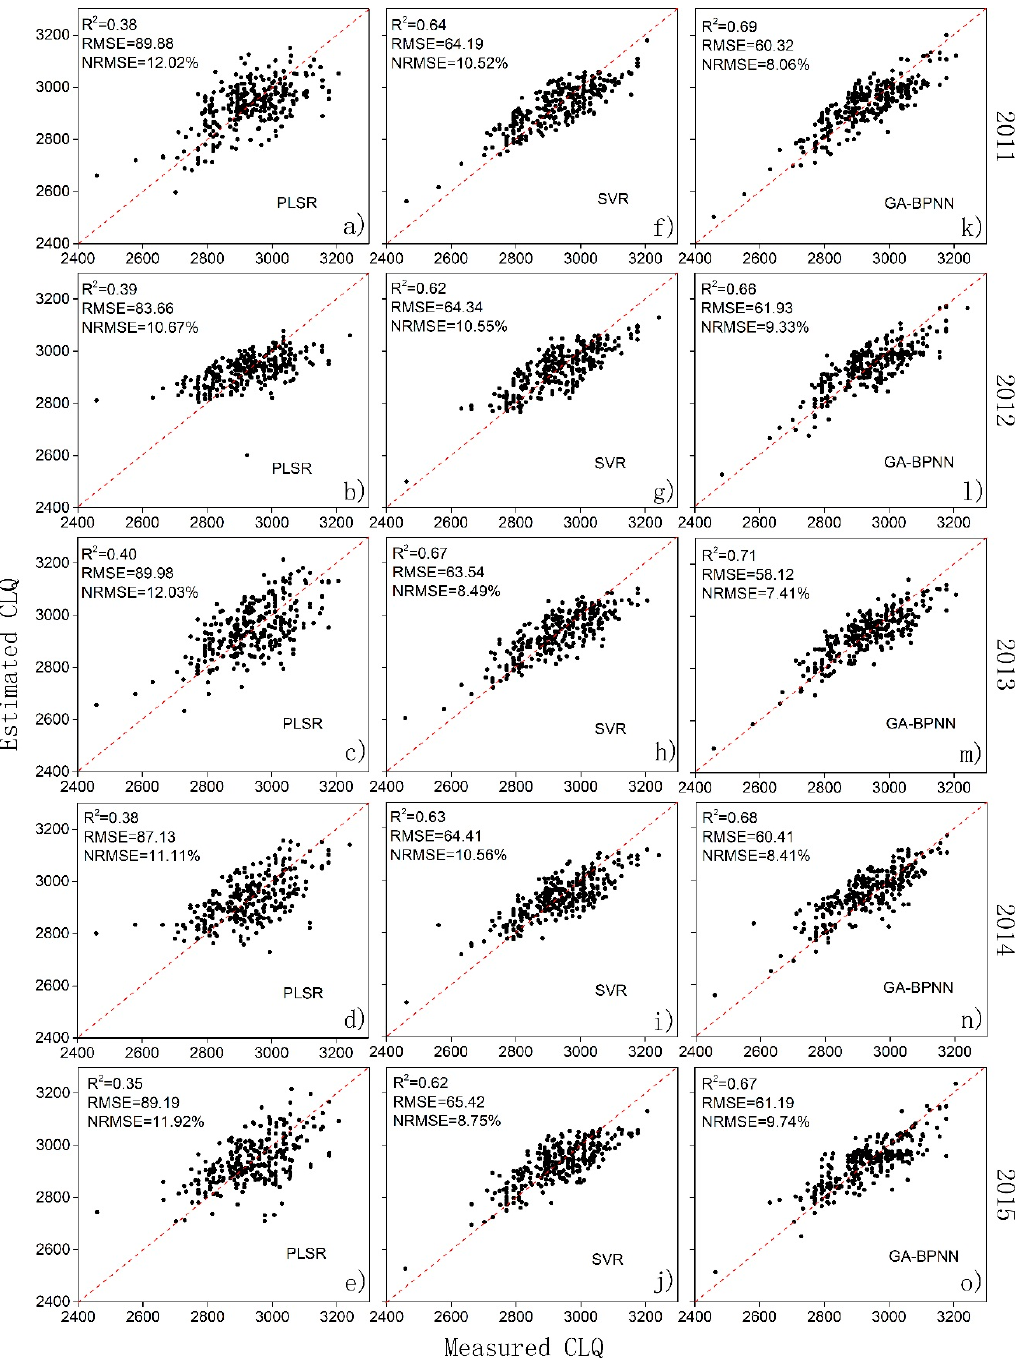
Figure 4. Scatterplots of measured versus estimated CLQ using the training dataset from 2011 to